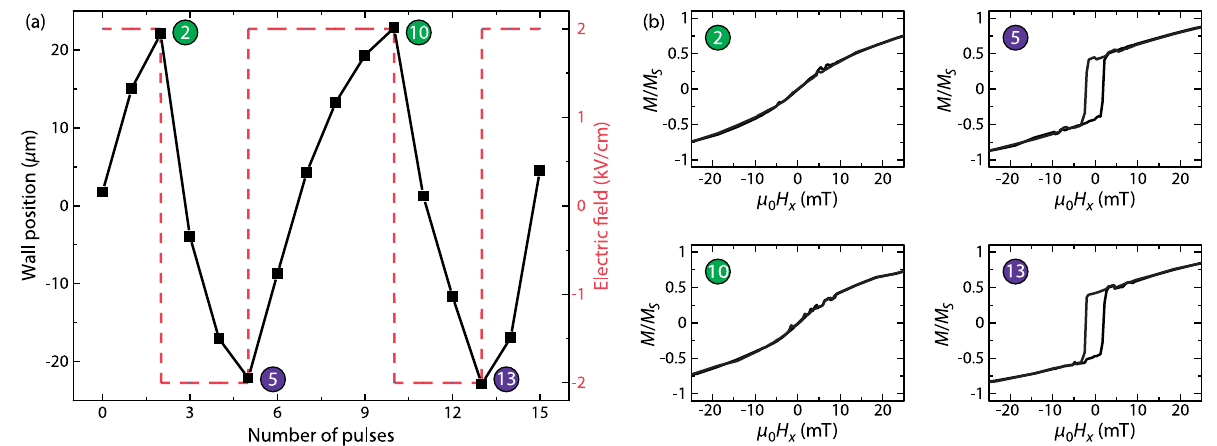
field.FIG. 4. (a) Magnetic domain-wall position in the Fe film after the application of a series of positive and negative electric-field pulses across the BaTiO 3 substrate. The polarity and strength of the electric field are indicated by a dashed red line. The numbers correspond